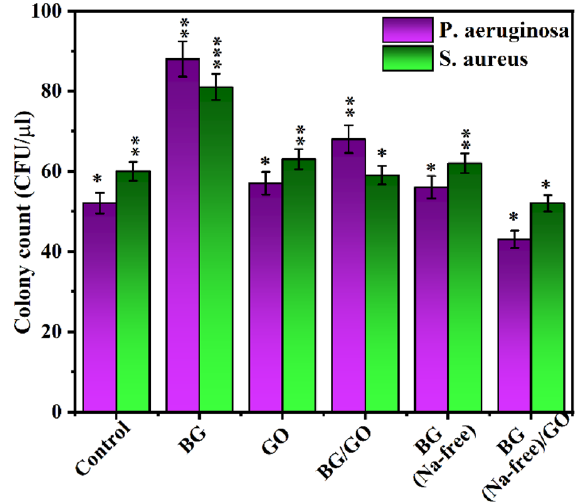
Figure 7. Antibacterial activity of BG, BG (Na-free), GO, BG/GO, and BG (Na-free)/GO nanocomposites against S. aureus and P. aeruginosa bacteria. The asterisks indicate significant difference *p < 0.02, **p < 0.03, ***p <